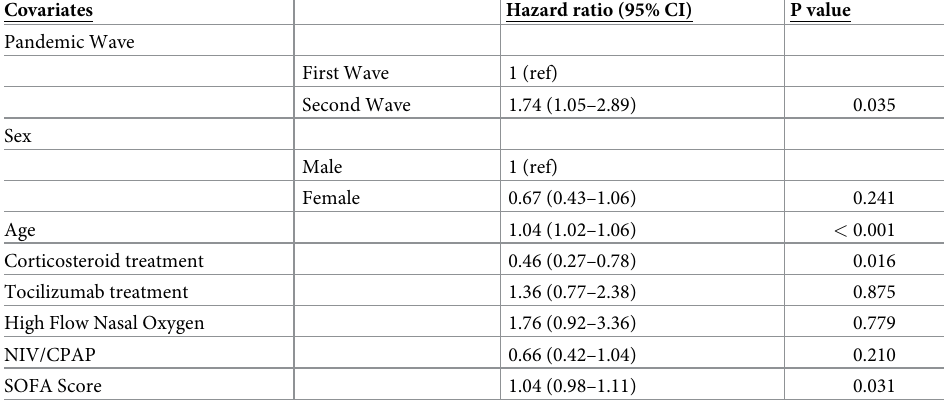
Table 2. Cox proportional risk analysis for mortality of all intubated and ventilated patients across both UK waves of the Sars-Cov-2 pandemic.